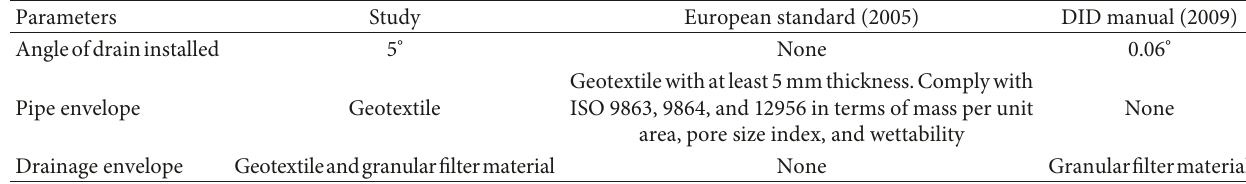
Table 6: Recommendation between study, European standard, and DID manual.